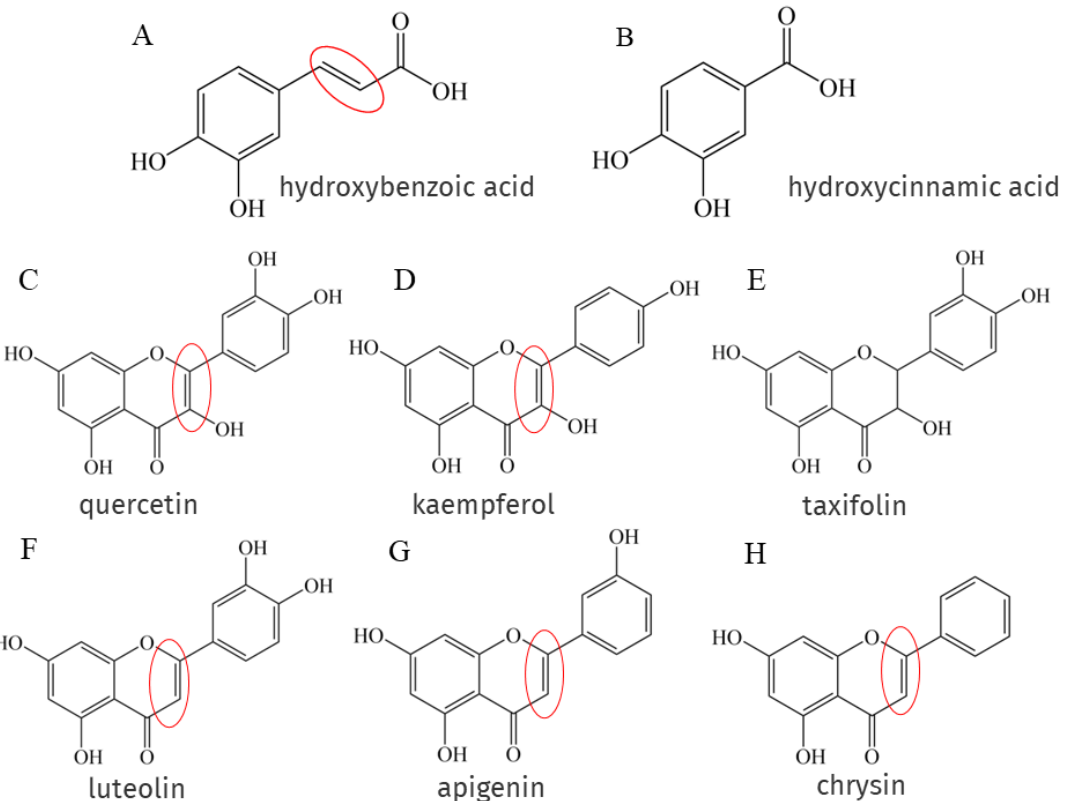
Figure 3. The characteristic double bonds of hydroxycinnamic acid and some flavonoids are specially marked with red circles.